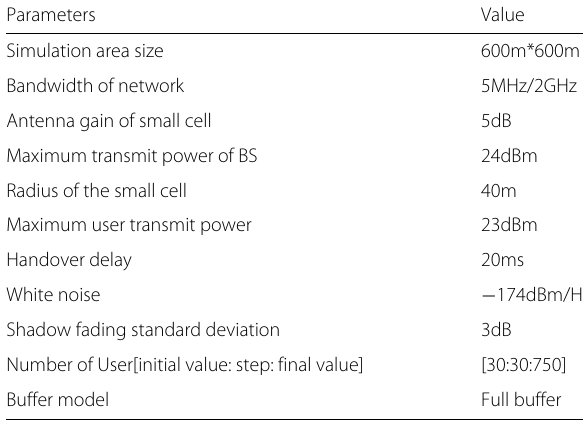
Fig. 5 Comparison scheduling case with other two algorithms Table 1 System